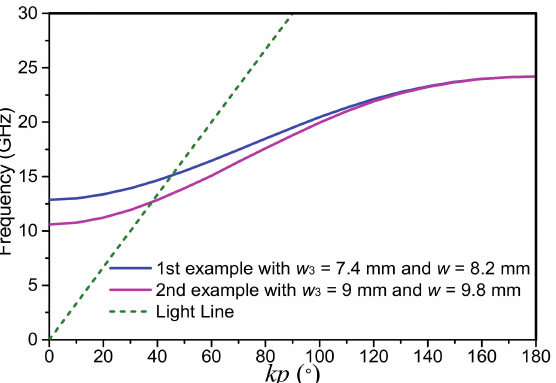
Figure 6. Dispersion characteristic comparisons between the SSPP unit cells with w 3 = 7.4 mm and w = 8.2 mm, and w 3 = 9 mm and w = 9.8 mm.